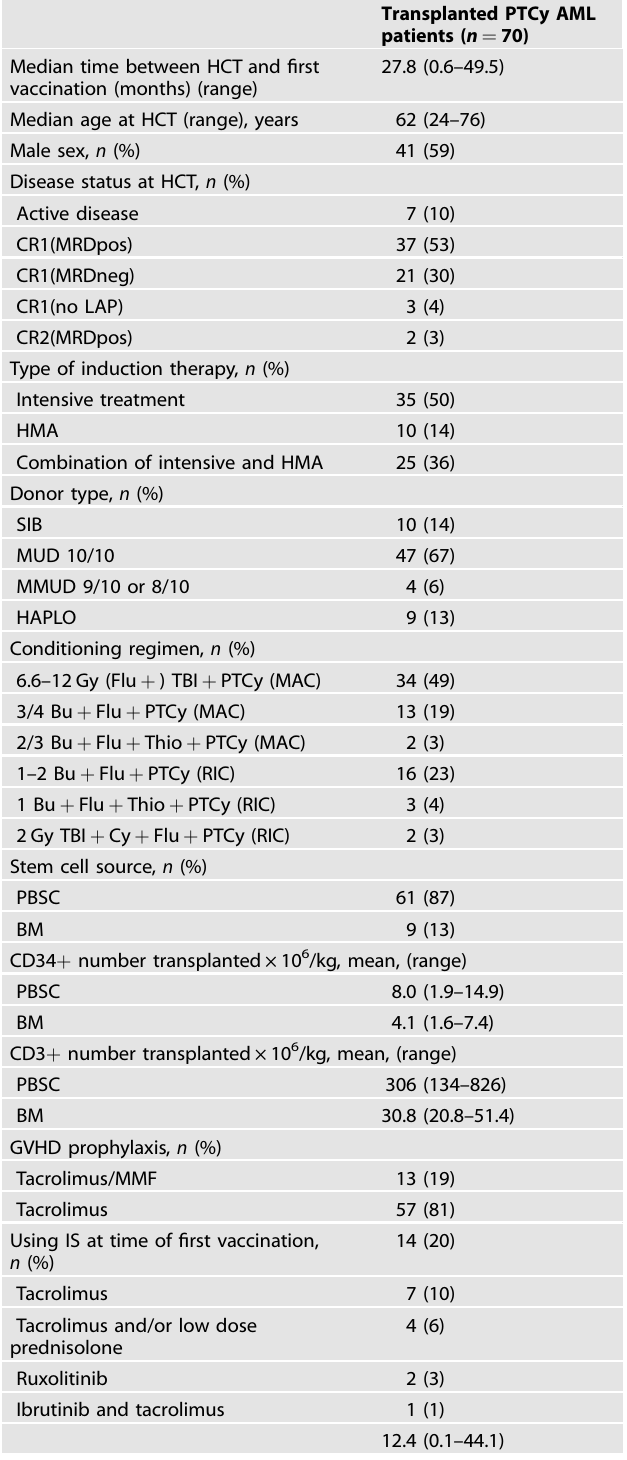
Table 1. Patient and treatment